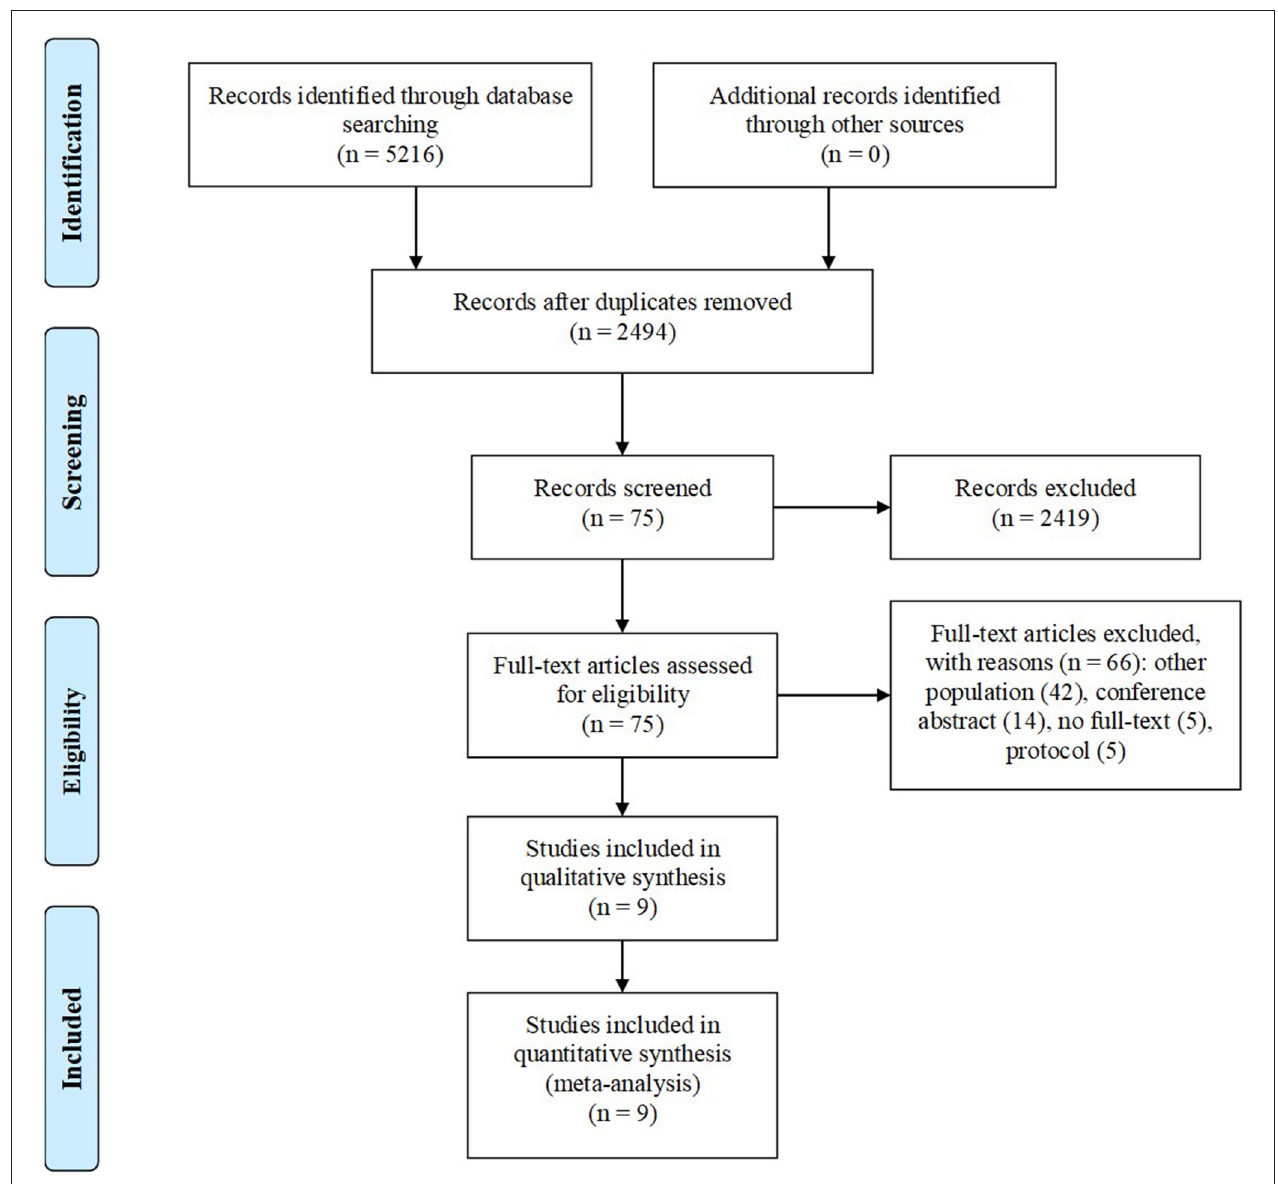
FIGURE 1 | Diagram flow of study